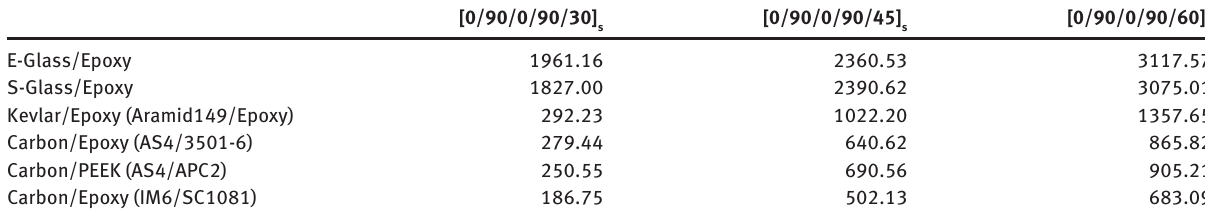
Table 12 Comparison of the critical energy release rate G (N/m) obtained from meshfree methods (Nodes: 11 × 23).